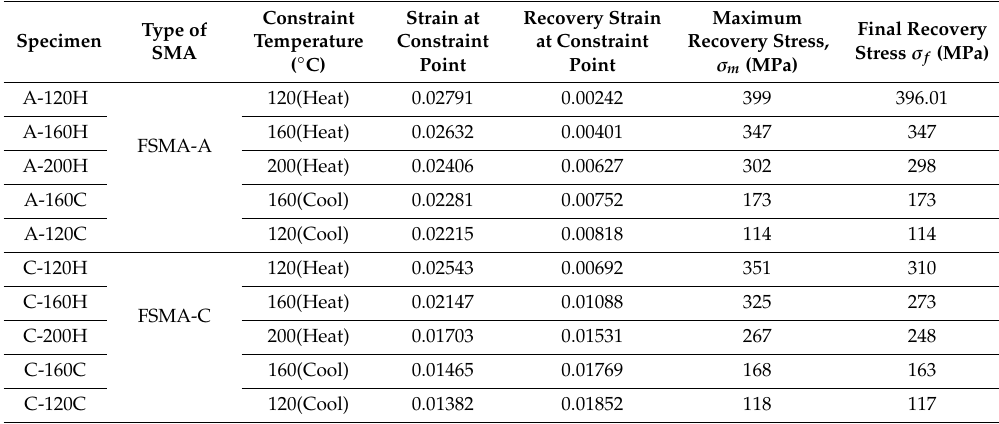
Figure4. Descriptionofpartialrestraint;( a )Stress-strainrelationship, ( b )Strain-temperaturerelationship Table 3. Details of variable and summary of activation test result under partial